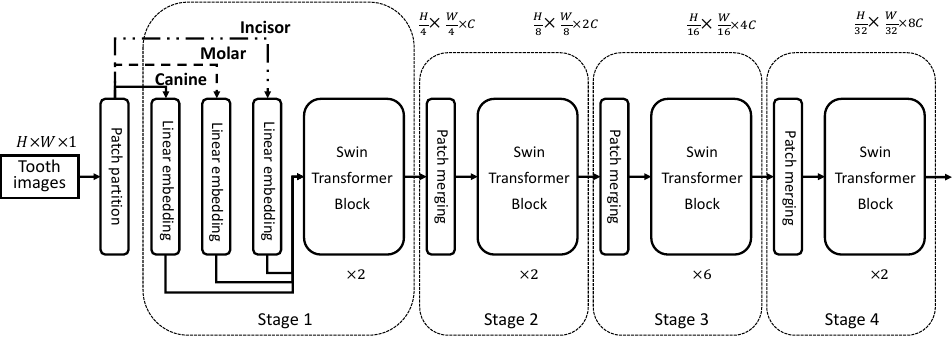
Figure 2. The overall framework of the proposed tooth type enhanced the swin transformer. We use different linear embeddings for different types of teeth and shared swin transformer blocks for all the teeth, which can model the tooth-specific and tooth-common characteristics, respectively. × n means n successive swin transformer